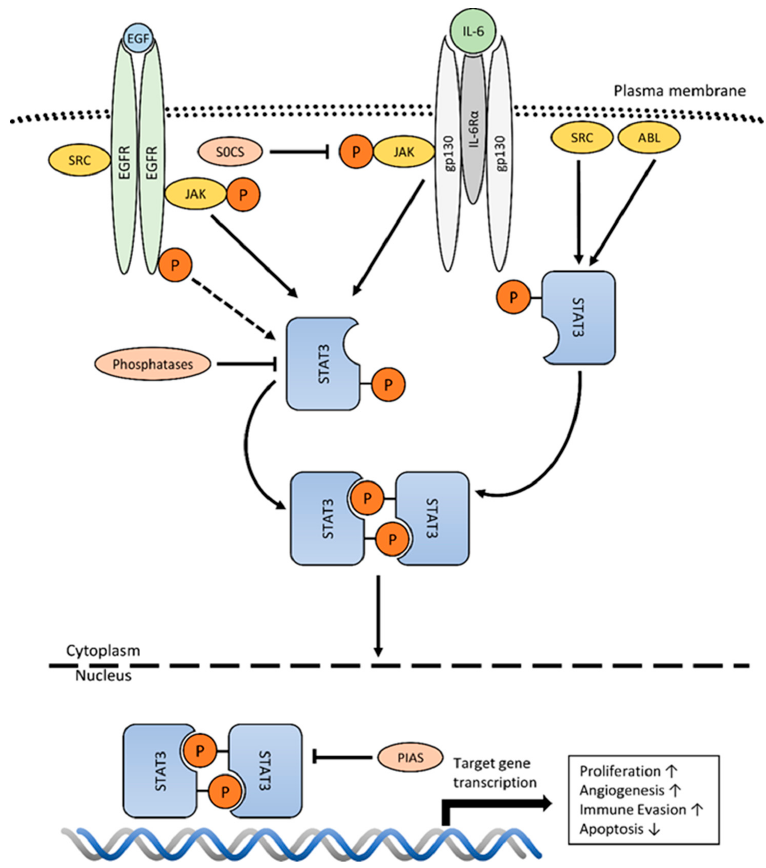
Figure 1. Mechanisms of STAT3 activation: Cytokine binding (e.g., IL-6) to its cognate receptor (e.g., gp130/IL-6R α ) induces receptor dimerization and activation of receptor associated Janus kinases (JAKs). Activated JAKs provide STAT3 receptor-docking sites by phosphorylation of cytoplasmic receptor tails (not shown). Subsequently STAT3 is activated by JAKs due to single tyrosine phosphorylation (Tyr 705 ). Formed STAT3-dimers translocate into the nucleus and drive transcription of genes associated with the cancer hallmarks: proliferation, angiogenesis, immune evasion and evasion of apoptosis (middle). Receptors with intrinsic kinase activity (RTKs) like EGFR also facilitate STAT3 activation via JAK engagement rather than directly (left). STAT3 activation has also been reported by non-receptor tyrosine kinases (nRTKs) like SRC or ABL (right). Under physiological